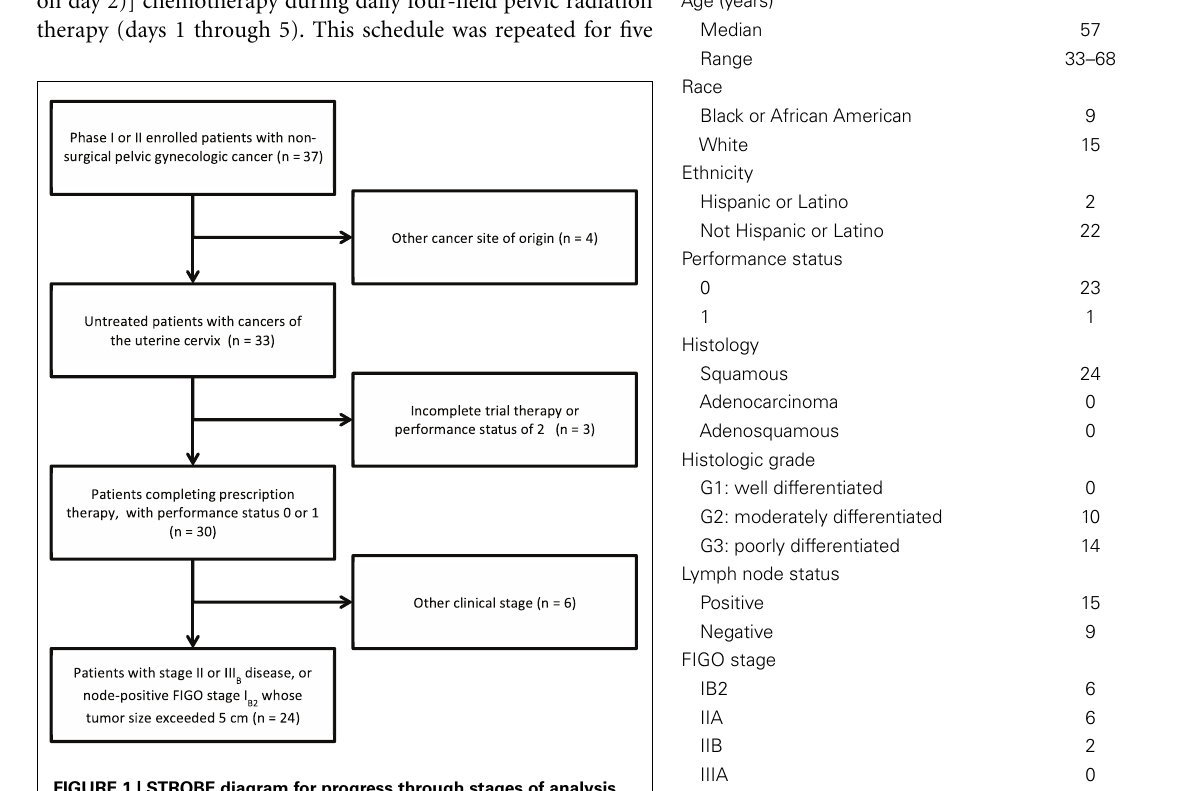
Table 1 | Pretherapy patient and tumor characteristics ( n = 24) .